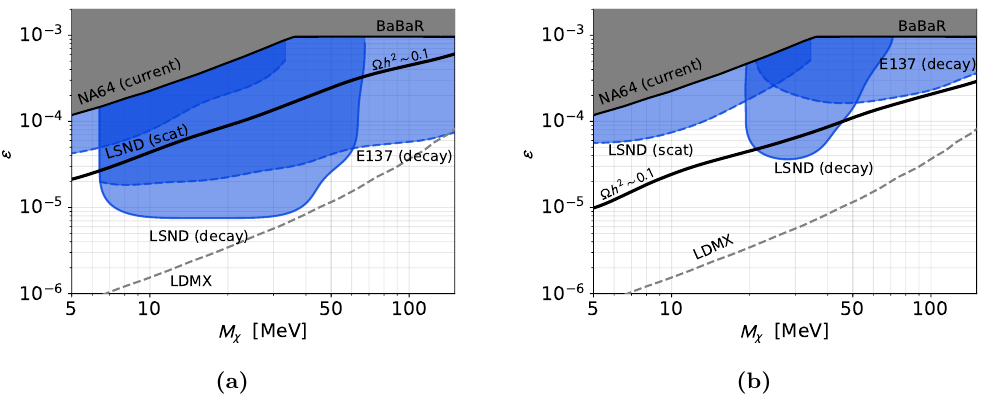
Figure 5. Bounds on the inelastic DM regime from the E137 [30], LSND [77] arising from DM scattering and (cid:31) 2 decay (blue shaded regions) and missing energy searches (grey regions and grey dashed line for the LDMX projection from [5]). The thick black lines correspond to points featuring the correct relic density of DM. We (cid:12)xed (cid:11) D = 0 : 1 ; y DM = 0 : 01 and varied M (cid:31) and " using the mass ratios M S : M (cid:31) : M V = 2 : 1 : 3 for (a) (cid:1) (cid:31) = 0 : 15 M (cid:31) and (b) (cid:1) (cid:31) = 0 : 05 M (cid:31)